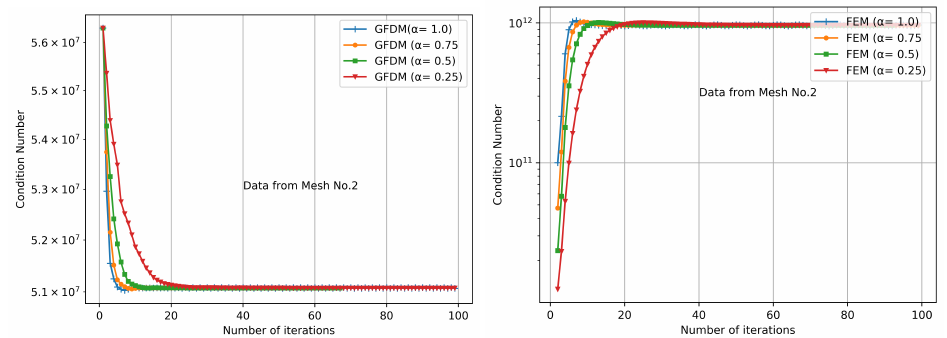
Figure 12. Jacobian condition number history on mesh no. 2 (refined